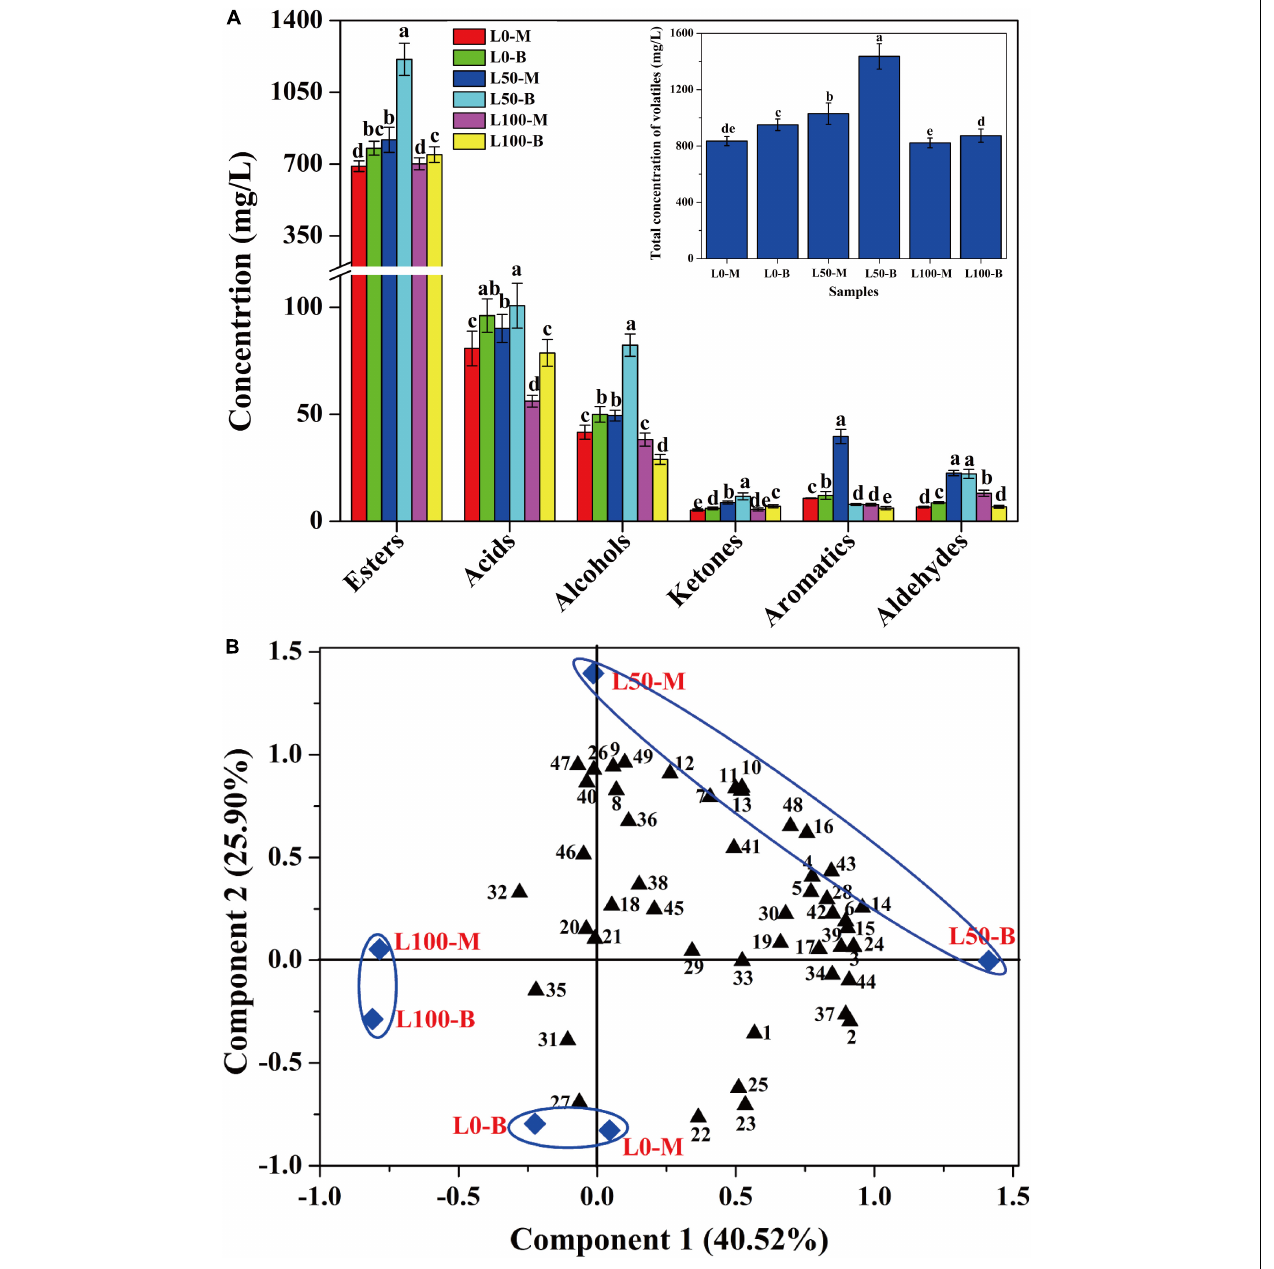
FIGURE 5 | Concentration variation (A) and principal components analysis (B) of volatile compounds in liquors distillated from different FG. Different letters obtained by ANOVA indicate significant differences at p < 0.05 ( n = 3). Each number in the atlas represents 1 compound, listed successively in Supplementary Table S3